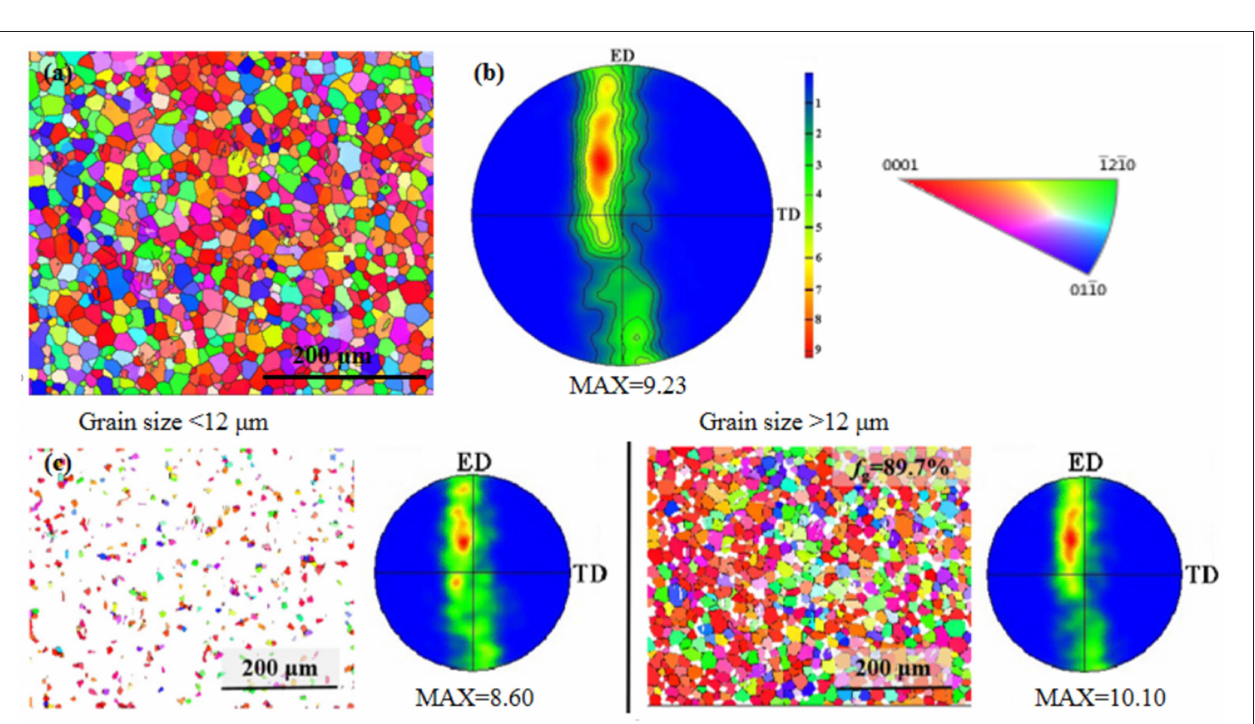
266 MPa, and 21%, respectively. Figure 7 gives the comparison Figure 6B represents the work-hardening rate curve based